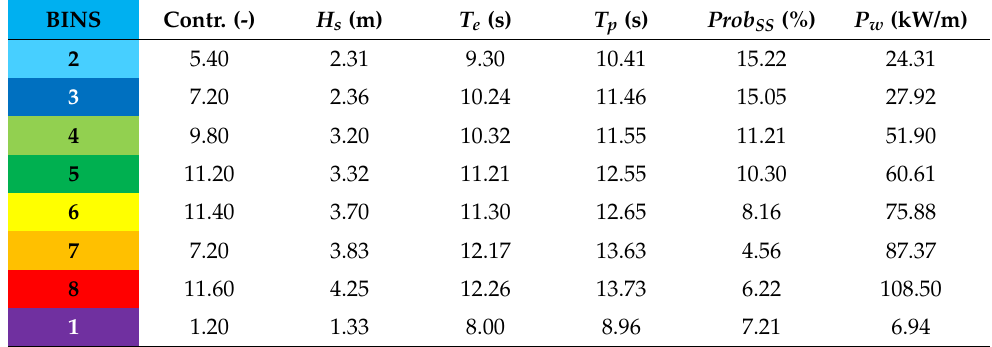
Table 3. Final bins considered in the experimental study with irregular waves, prototype